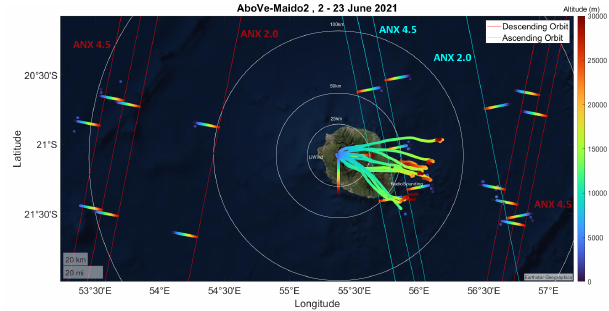
Figure 2. AboVE-OHP-2 campaign overview with ascending and descending overpasses in cyan and red. The colored trajectories rep- resent the ascending phase of the radiosondes, with their altitude shown through a color map. The straight colored strokes represent lidar measurements from Aeolus and the ground-based lidar. Credit: base map source is Earthstar